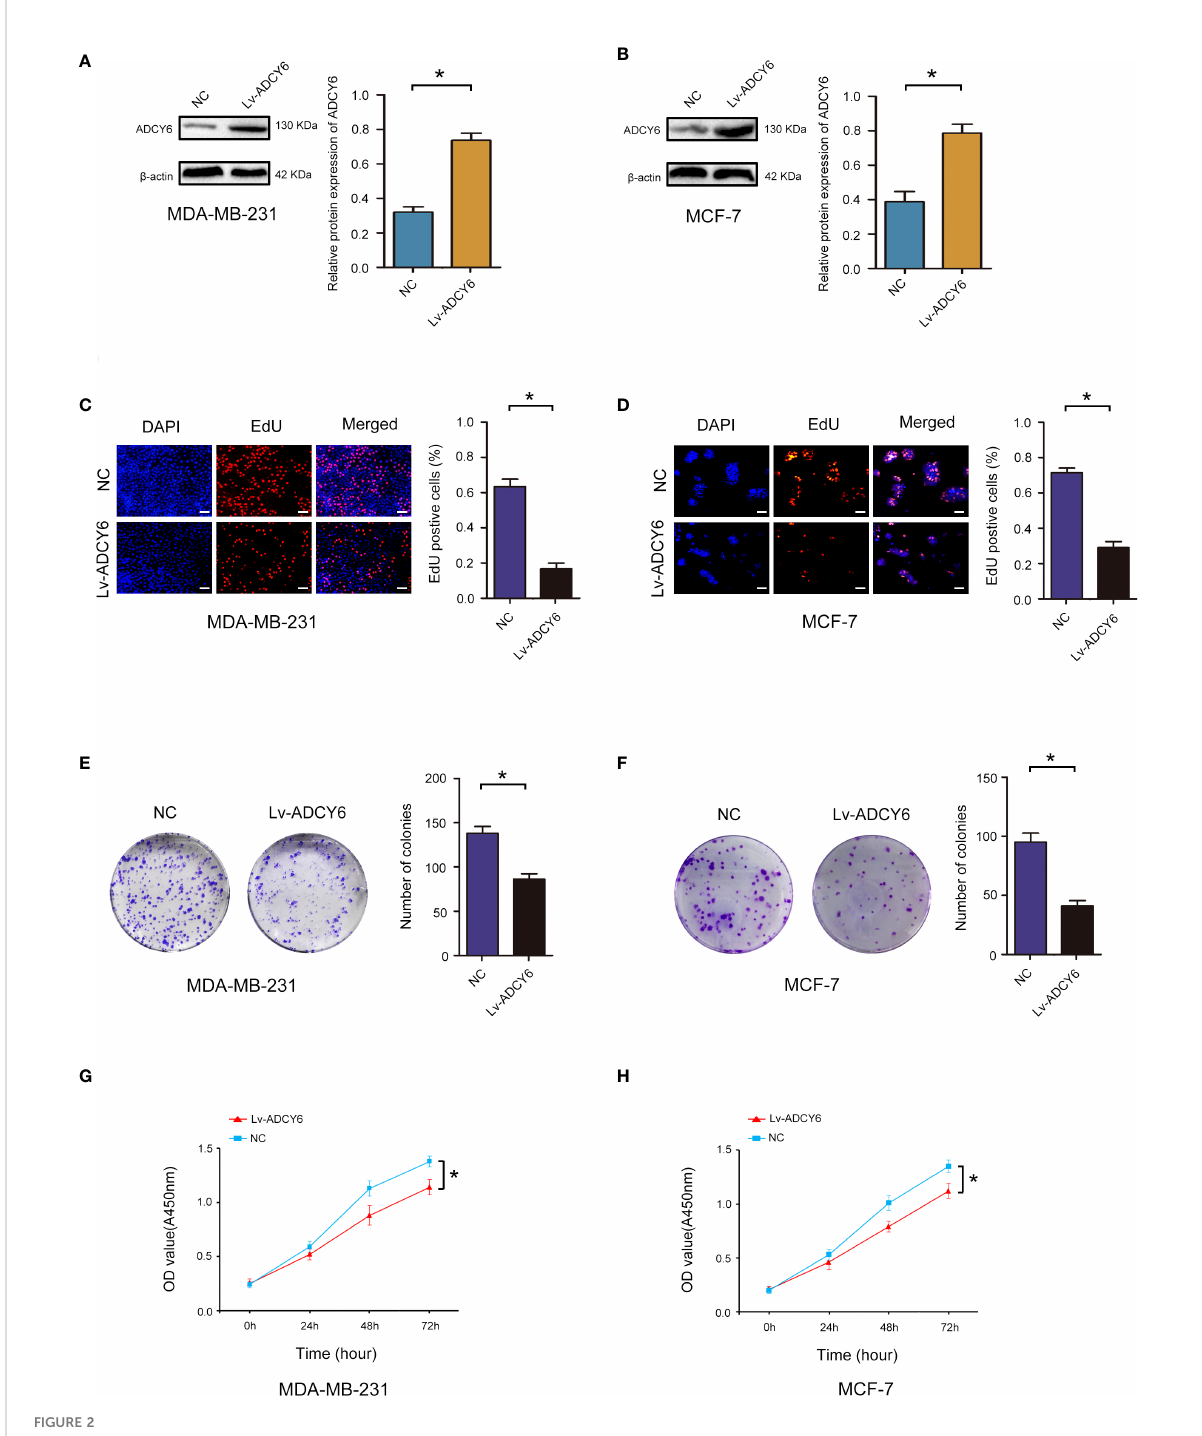
FIGURE 2 ADCY6 signi fi cantly suppressed the proliferation of breast cancer cell lines. (A) Western blot assay showing the protein expression of ADCY6 in ADCY6 increased (Lv-ADCY6) MD-MBA-231 cells. *p < 0.05 versus controls. (B) Western blot assay showing the protein expression of ADCY6 in ADCY6 increased (Lv-ADCY6) MCF-7 cells. *p < 0.05 versus controls. (C) EdU assay to detect the uptake of EdU in MD-MBA-231 cells. Scale bars, 50 µm. *p < 0.05 versus controls. (D) EdU assay to detect the uptake of EdU in MCF-7 cells. Scale bars, 50 µm. *p < 0.05 versus controls. (E) Colony formation assay to detect proliferation in MD-MBA-231cells. *p < 0.05 versus controls. (F) Colony formation assay to detect the proliferation of MCF-7 cells. *p < 0.05 versus controls. (G) CCK-8 assay to detect the proliferation of MD-MBA-231 cells. *p < 0.05 versus controls. (H) CCK-8 assay to detect the proliferation of MCF-7 cells. *p < 0.05 versus